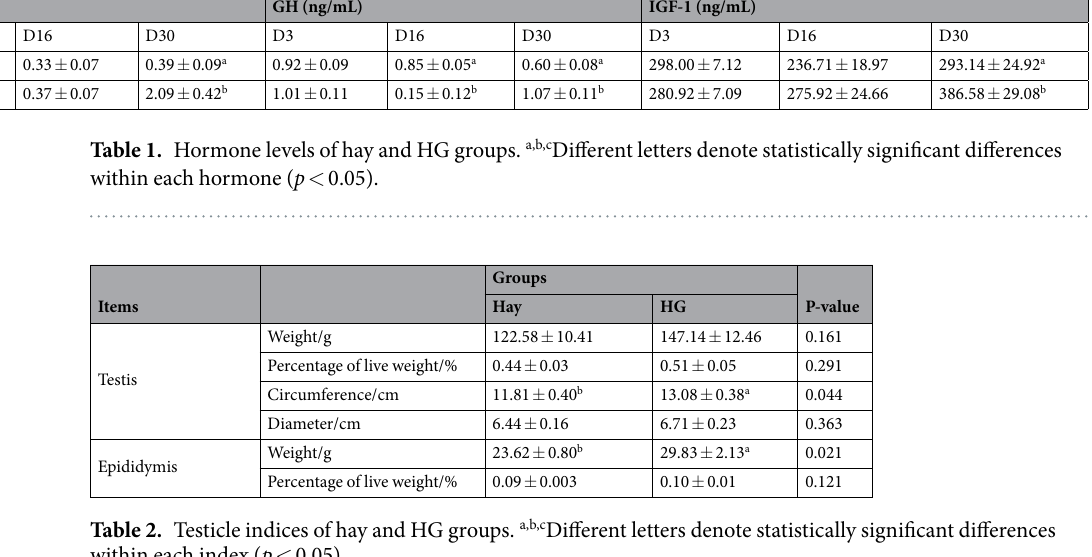
lncRNAs and 35% of the mRNAs and transcripts expressed lower than 1 RPKM (Fig. 5a and b). The expression level of the lncRNA transcripts was relatively lower than those of the mRNA in both the hay and HG diet groups (Fig. 5c and d). In total, based on adjusted P-value threshold of < 0.001 and |log2(fold change)| > 1, there were 28 upregulated and 31 downregulated lncRNA DE transcripts, and 127 up-regulated and 102 down-regulated mRNA DE transcripts in the HG group (Fig. 6a and b). To further evaluate the reliability of RNA sequencing, 20 DE lncRNAs and mRNA transcripts were randomly selected to validate the relative expression levels in the sheep testis of the hay and HG diet groups using qRT-PCR.